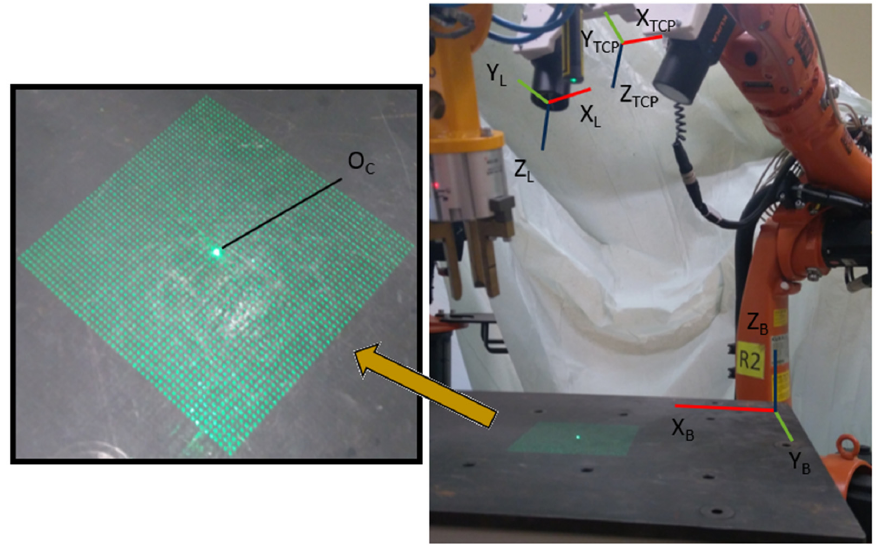
Figure 8. Laser grid of points projected onto X B Y B projection plane.